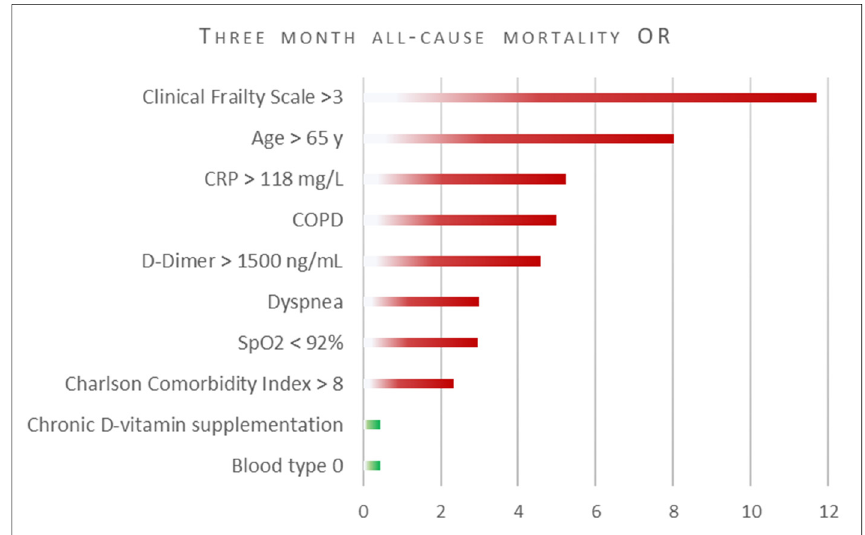
Figure 1. Clinical characteristics affecting 3-months mortality. Univariable logistic regression. Legend: COPD—chronic obstructive pulmonary disease; OR—odds ratio; SpO2—blood oxygen saturation (pulse oximetry finger probe). All lab test results obtained upon admission to the hospital.